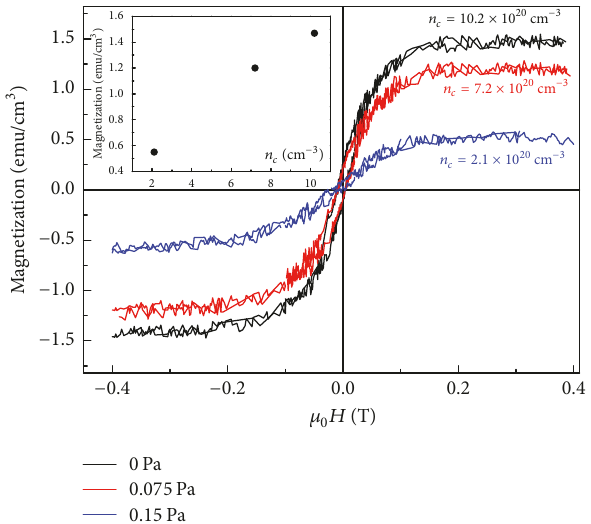
Figure 3: Room temperature magnetization versus applied field loops for 5.4 at.% Co-doped ITO thin films grown under varying oxygen partial pressures. Corresponding carrier concentrations are also given. Inset: room temperature magnetization as a function of carrier concentration for the same